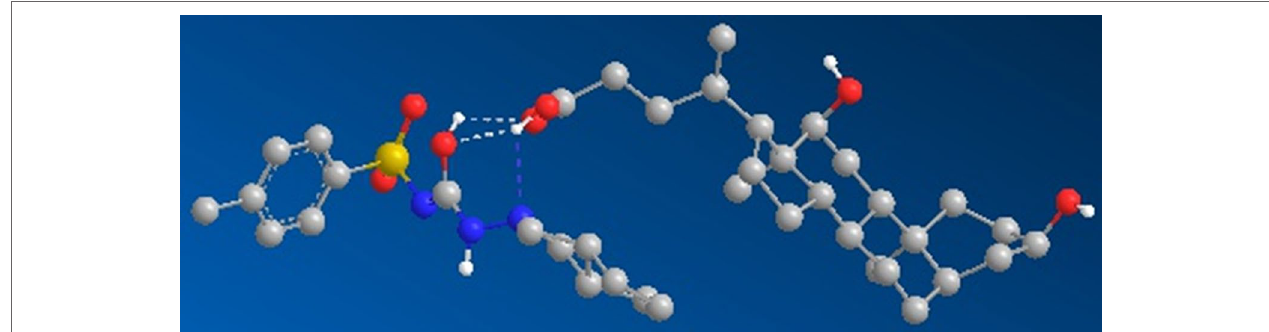
FIGURE 4 | Geometrically optimized three-dimensional structure of the gliclazide-DCA complex.